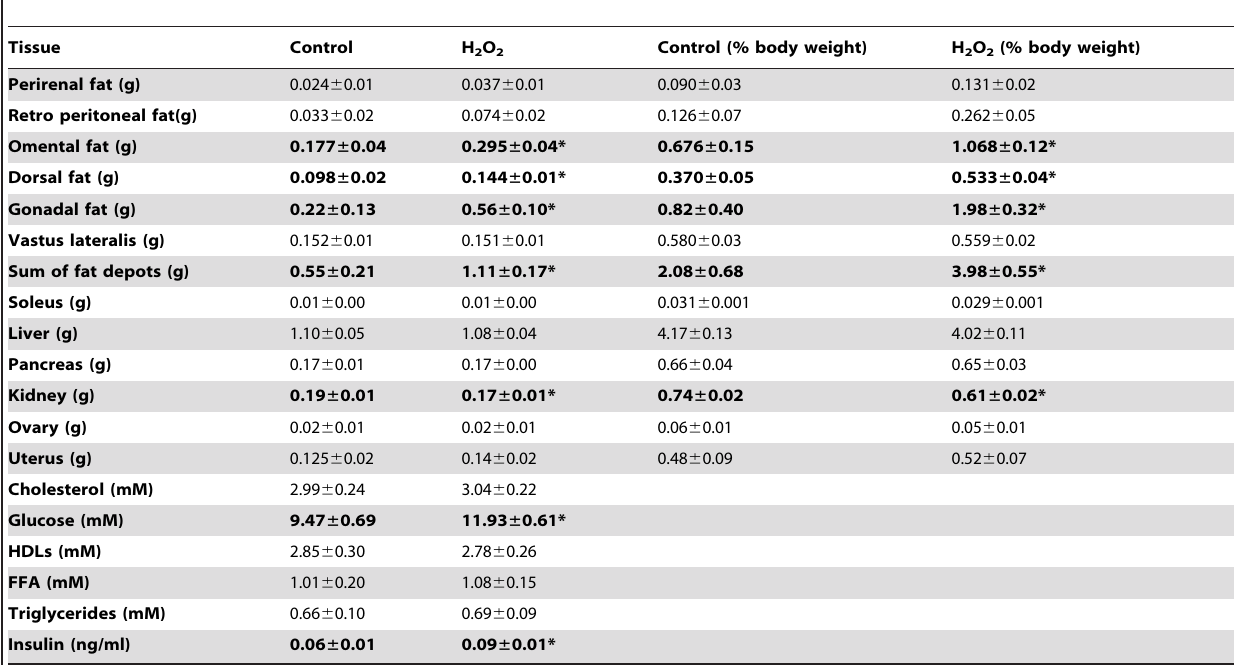
Values represent mean 6 SEM. Control n=7 females from 6 litters, H 2 O 2 n=9 females from 5 litters representative of 15 stud CBAF1 males. *Indicates significantly different from control female offspring (also indicated by bold text) (P , 0.05).